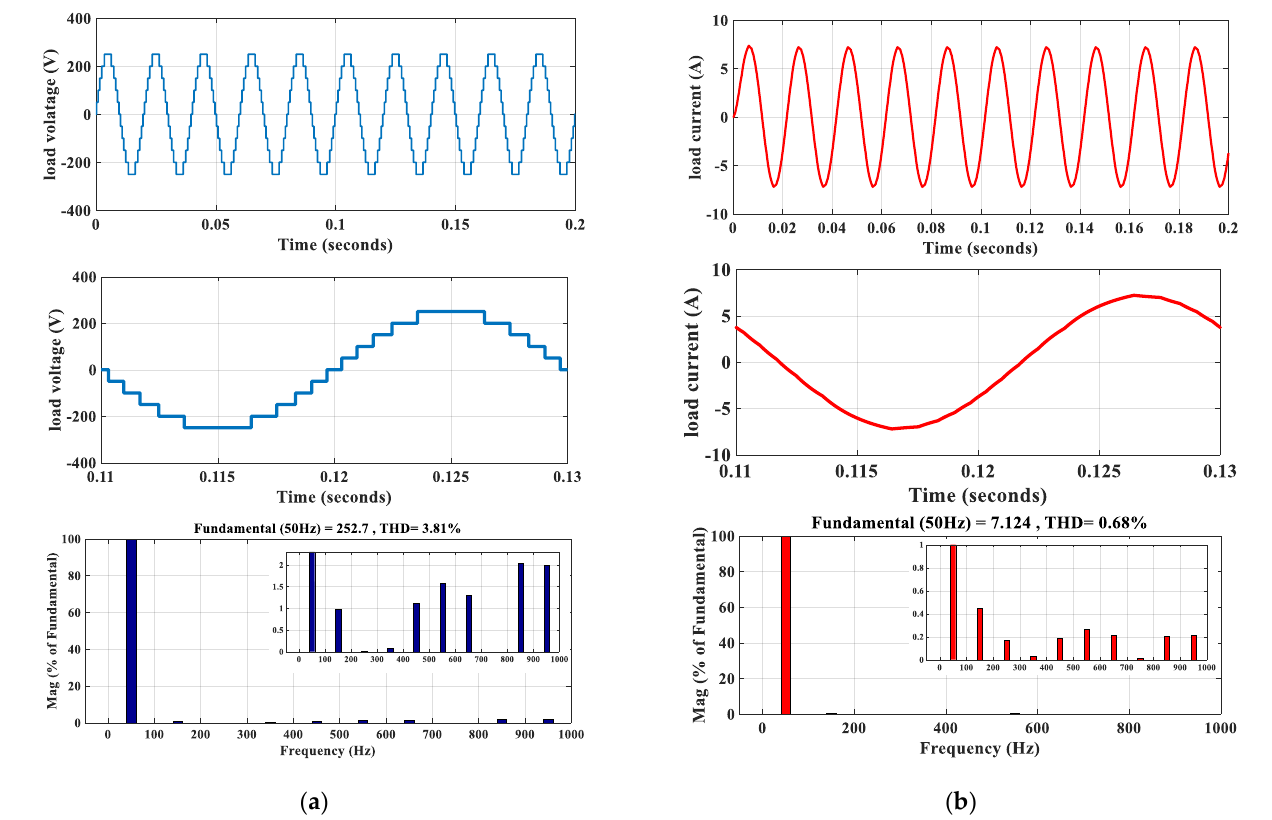
Figure 14. Load voltage and current simulation waveforms under healthy operation. ( a ) voltage waveform ( b ) current waveform.